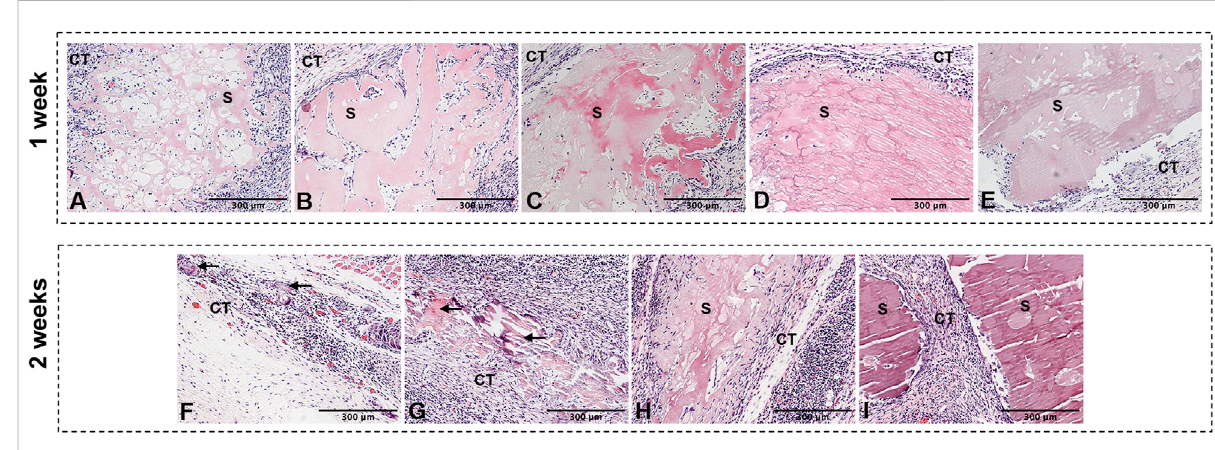
FIGURE 3 Photomicrographs of hematoxylin and eosin of (A) 0w/v group (B) 0.01%w/v group, (C) 0.1%w/v group (D) 0.5%w/v group, (E) 1%w/v group retrieved at 1 w and (F) 0.01%w/v group (G) 0.1%w/v group, (H) 0.5%w/v group (I) 1%w/v group retrieved at 2 w postoperatively. (S: scaffold, CT: connective tissue, Black triangular arrows indicate scattered scaffold